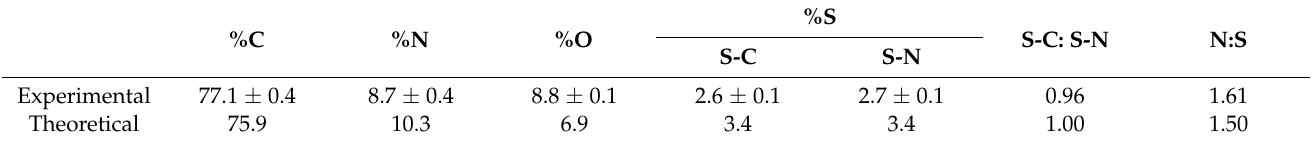
Table 2. XPS analysis of poly( St-D - alt - Ma-A ) brushes obtained via surface-initiated RAFT polymerization.